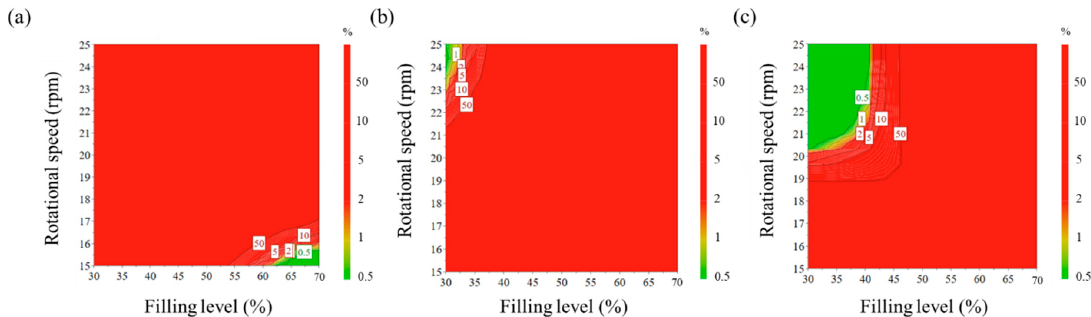
Figure 4. Design spaces to optimize process parameters of blending for amlodipine formulation: blending time at ( a ) 9 min, ( b ) 16.5 min, and ( c ) 24 min. The yellow spaces are parts that satisfy all the target values of IQAs.